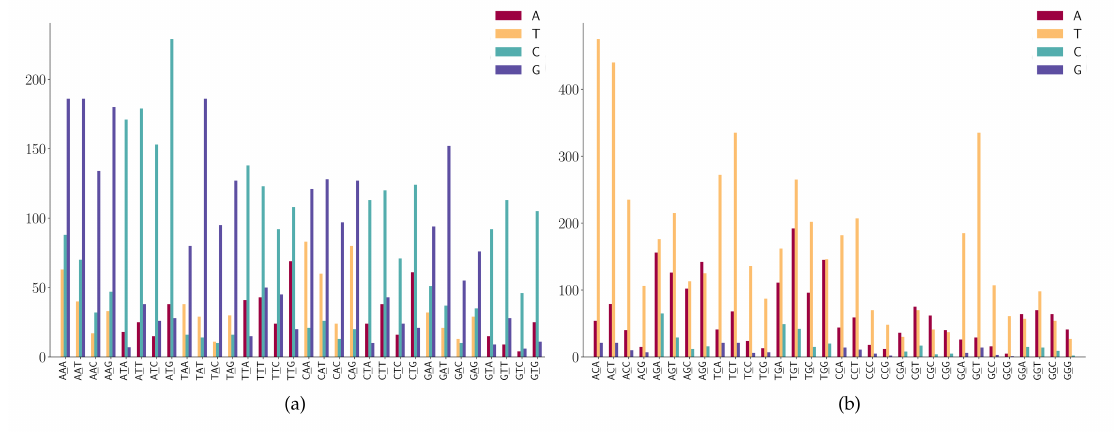
Figure 8. SNP frequency at the second position of 3-mer motifs. ( a ) A or T is at the second position of 3-mer motifs. ( b ) C or G is at the second position of 3-mer